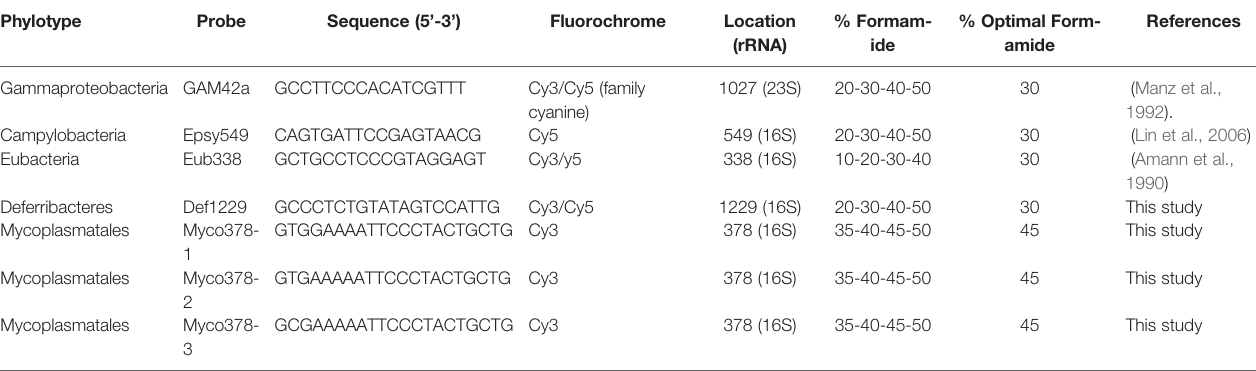
TABLE 2 | Probes used for this